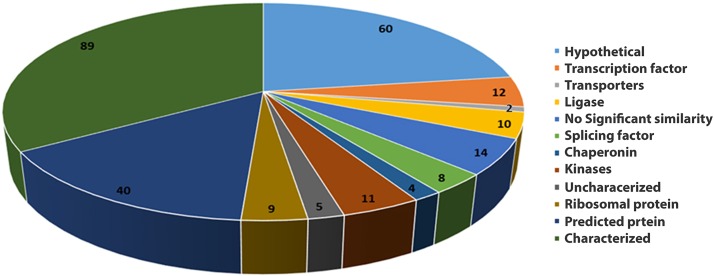
Functional relevance of mulberry EST sequences annotated using NCBI database.